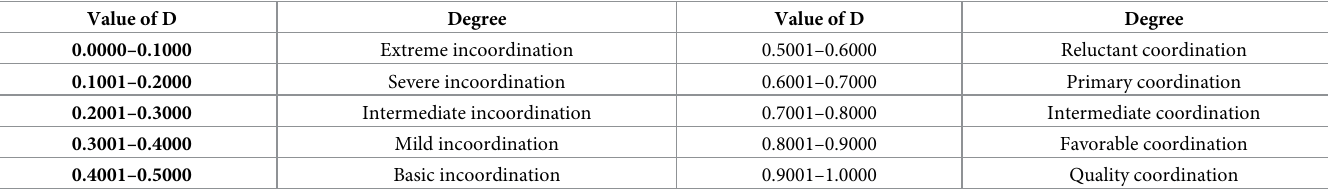
Table 1. Classification of coupling coordination